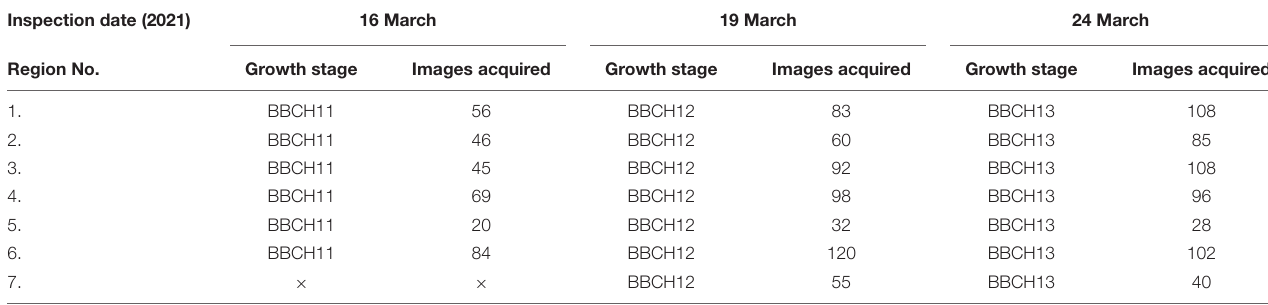
FIGURE 2 | Study site and experimental design. (A) Location of the study site; (B) orthomosaic; (C) field tray nursing seedling experiment designs. TABLE 1 | Details of RGB images acquisition and the corresponding phenological growth stages of the rice